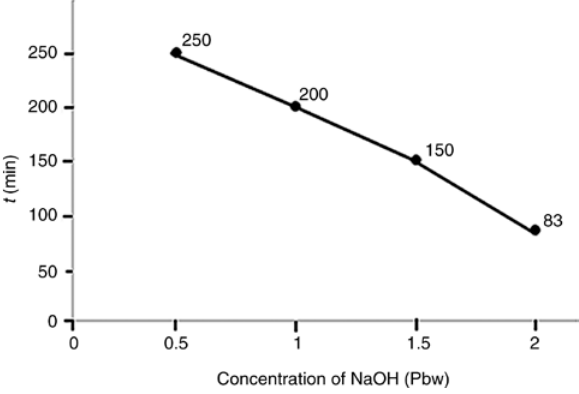
as the solid support 2